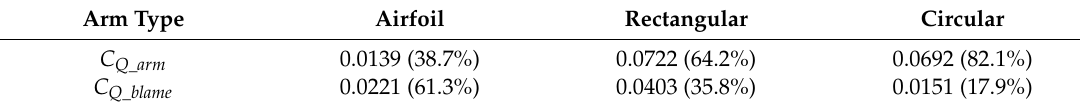
Table 9. Resistance torque coe ffi cients in arms and